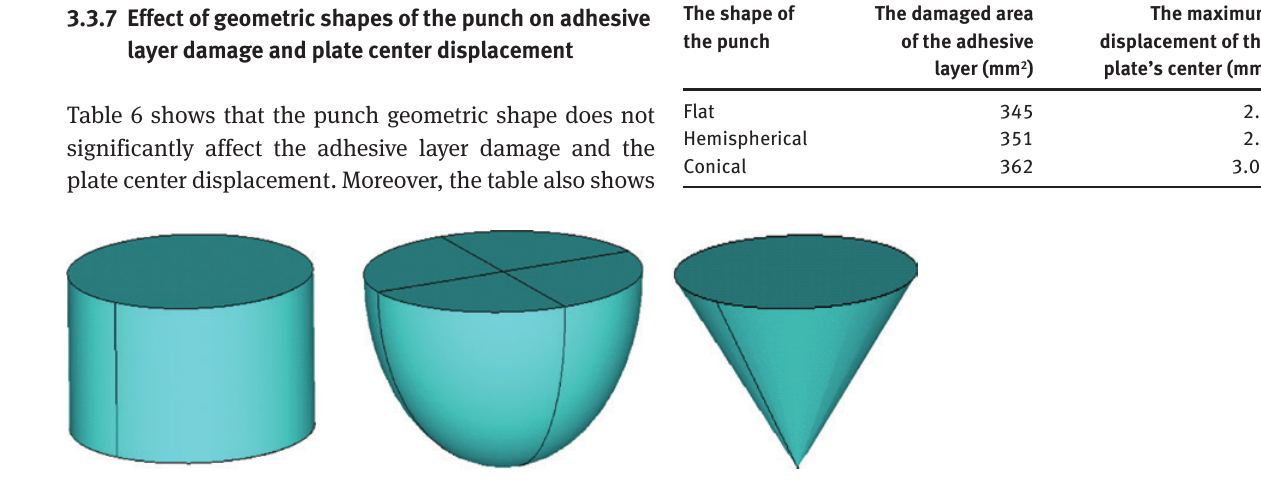
Figure 18: The schematic diagram of the impactor geometric shapes (flat, hemispherical, and conical).